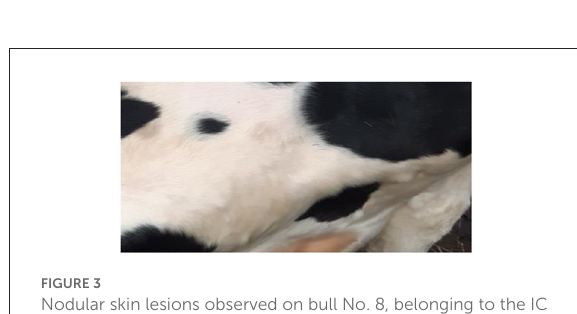
FIGURE3 Nodular skin lesions observed on bull No. 8, belonging to the IC group, 16 dpi.